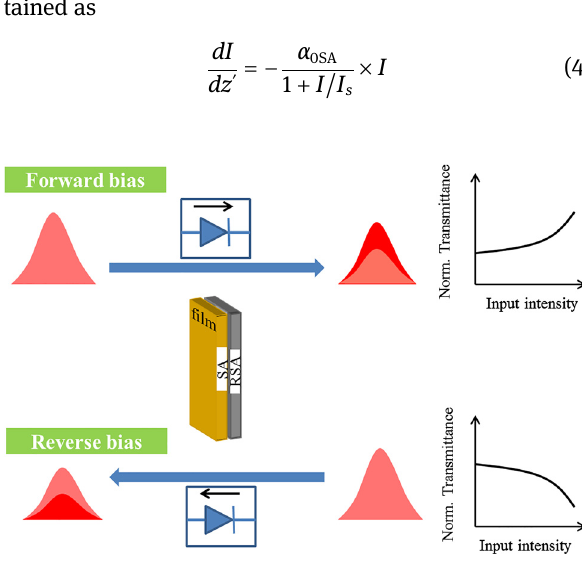
Figure 4: Action of an all-optical diode based on asymmetric nonlinear absorption. Dark red represents nonlinear transmission, light red represents linear